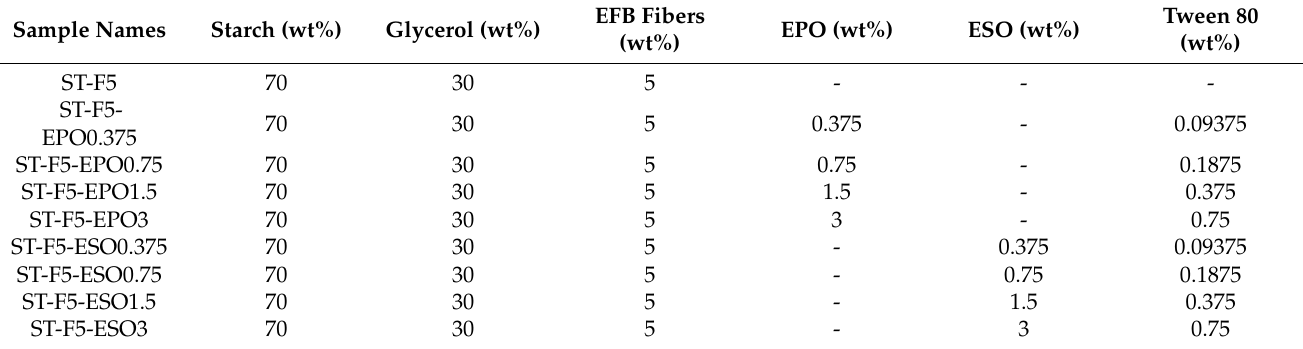
Table 1. Formulations for starch/empty fruit bunch (EFB)-based bioplastic